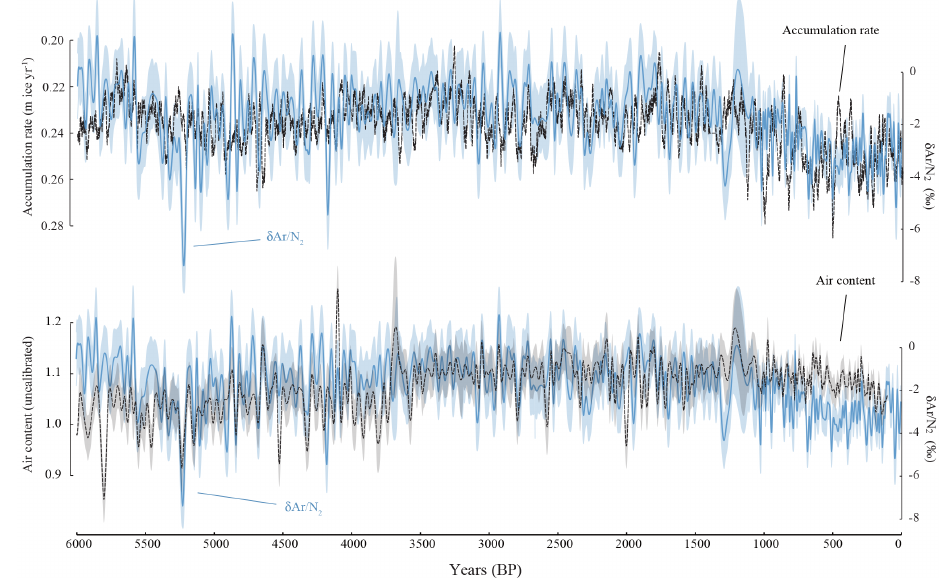
Figure 1. δ Ar / N 2 vs. accumulation rates or air contents in GISP2 over the past 6000 years. Note that δ Ar / N 2 are corrected values for the post-coring fractionation (1.5‰ added). A spline with a 21-year cut-off period (blue line) was applied to the δ Ar / N 2 data. Two σ error bounds are shown, which were estimated by 1000 iterations of Monte Carlo simulations. Accumulation rates (miceyear − 1 ) (black line) were filtered by 21-year RMs. Note that the y axis for the accumulation rate is reversed. δ Ar / N 2 vs. accumulation rates are significantly negatively correlated over the past 6000 years ( r = − 0 . 35, p = 0 . 03). δ Ar / N 2 and air contents are significantly positively correlated over the past 6000 years ( r = 0 . 38, p < 0.001 after linear detrending). A slight shift of the air contents around 3700BP is probably due to the analytical changes that occurred between two different periods of measurements (Kobashi et al., 2008b). The correlations between δ Ar / N 2 and air contents before and after 3700BP are similar and significant ( r = 0 . 30, p = 0 . 002 and r = 0 . 26, p = 0 . 008, respectively). Therefore, the δ Ar / N 2 variation can explain 7–14% of the total variance of the air contents.